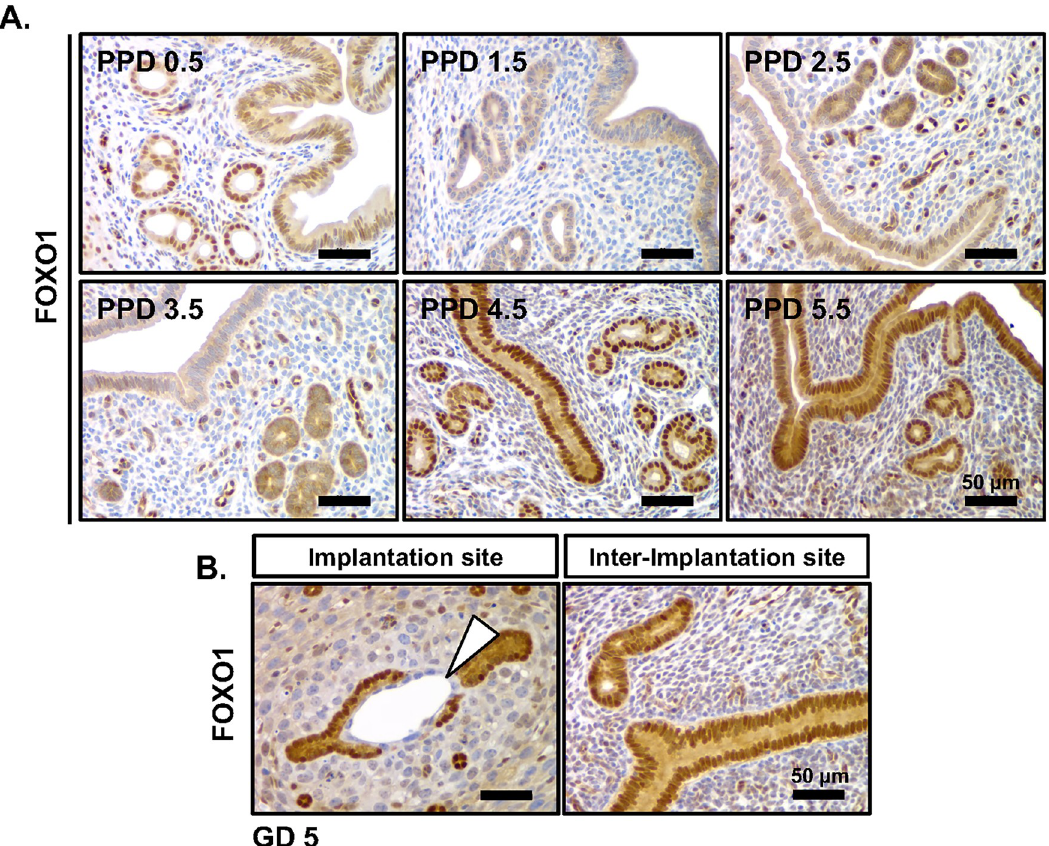
Fig 1. Endometrial expression of FOXO1 during the preimplantation period in the uteri of pseudopregnant mice. (A) Immunohistochemical staining for FOXO1 in endometrial cross sections of pseudopregnant (PP) mice ( n = 3). (B) Immunohistochemical staining FOXO1 in sagittal sections of the implantation site (IS) and inter-implantation site (I-IS) in the afternoon of the window of receptivity (gestational day 5, GD 5)( n = 3). Blastocyst indicated by the white triangle. Scale bar, 50 μ m.